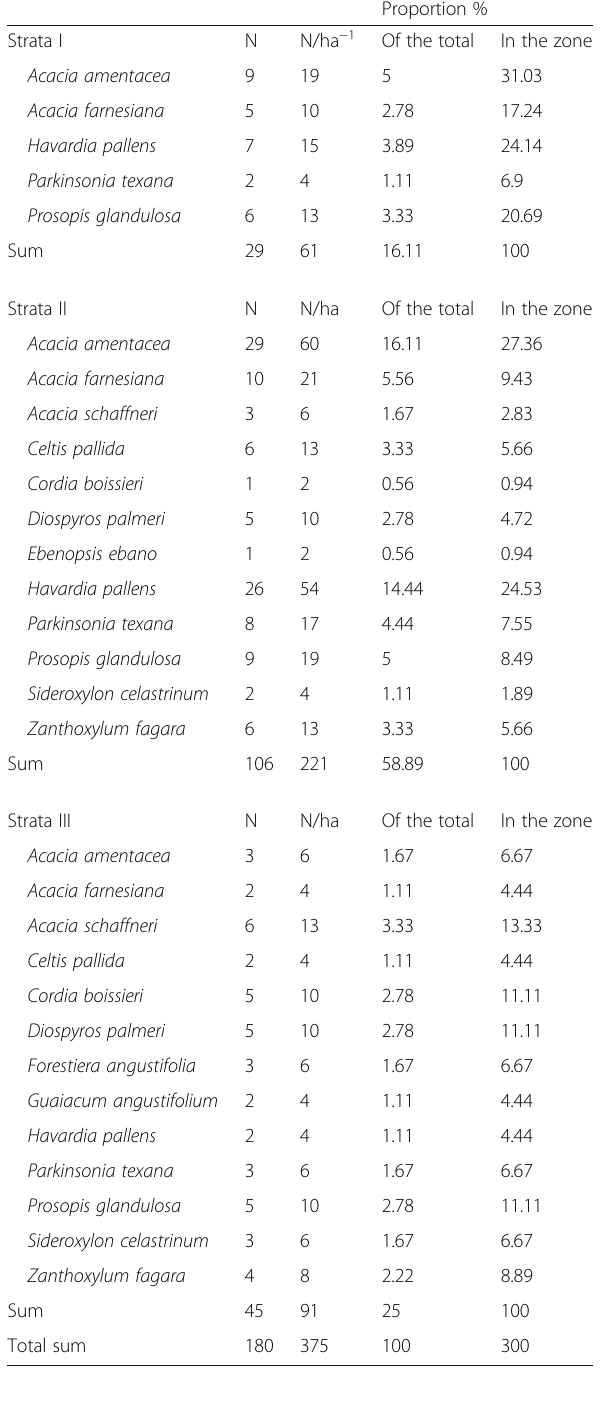
Table 3 Absolute Abundance (N/ha) and proportional abundance (of the total, and in the zone) with respect to height strata of the registered species. High strata (7.20 – 9.00 m), medium strata (4.50 – 7.19 m) and low strata (< 4.50 m)